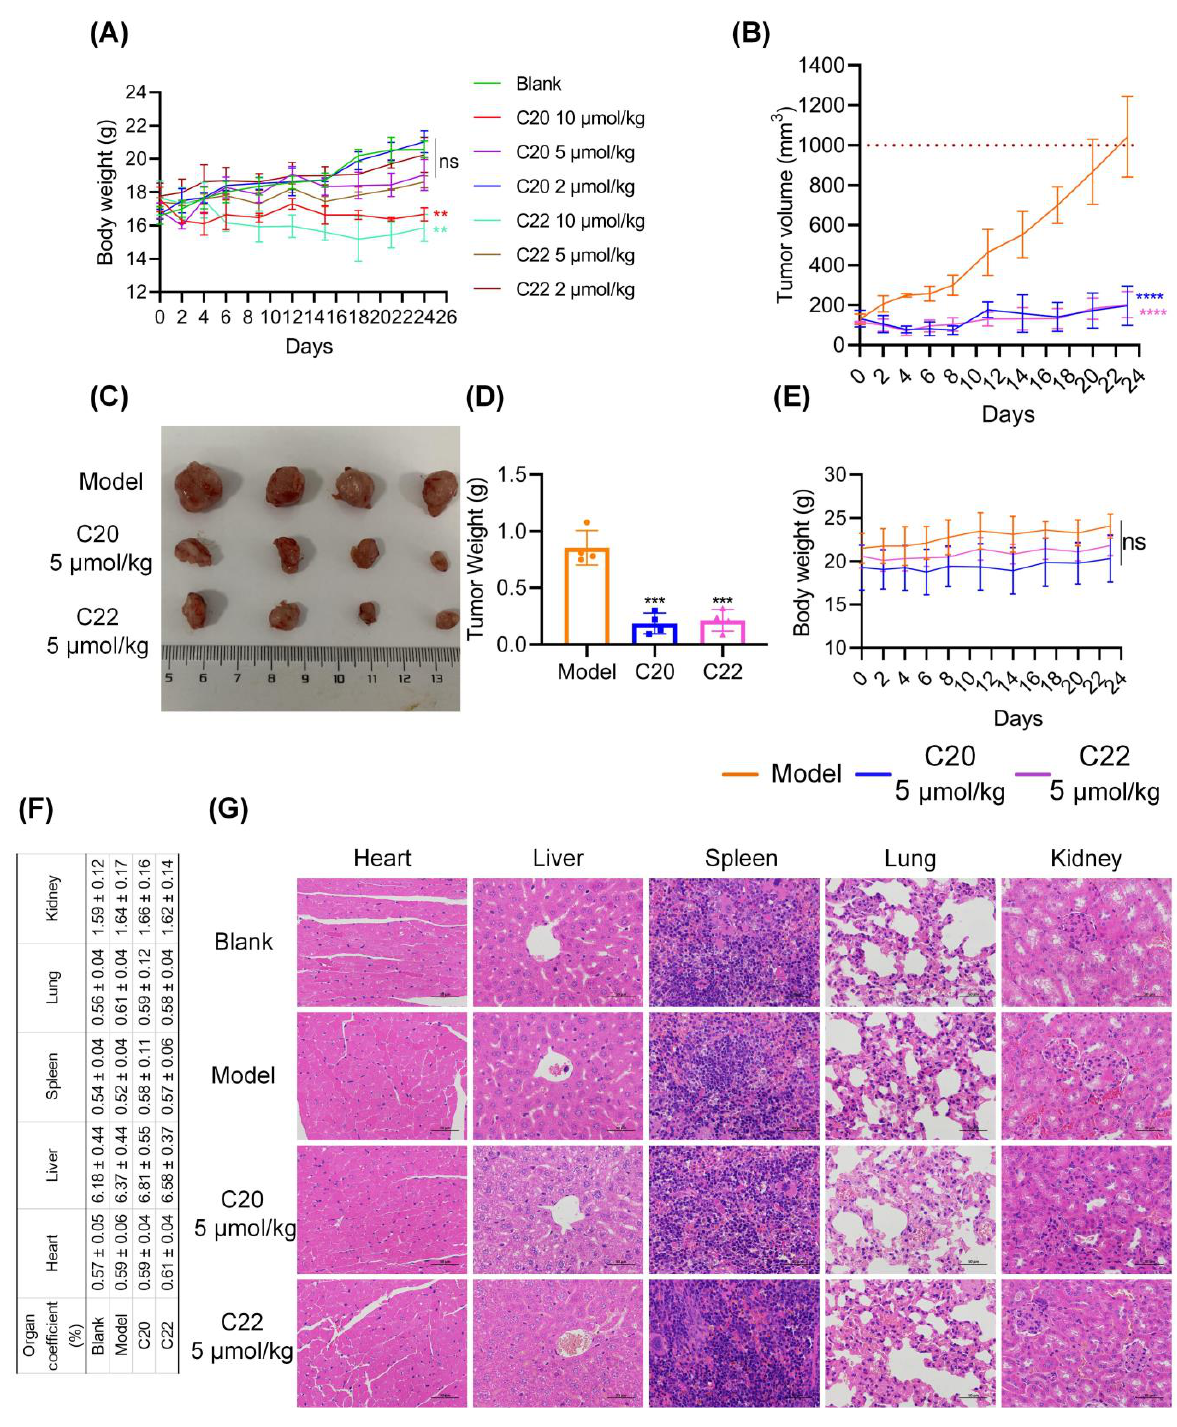
Figure 9. The toxicity and antitumor effects of C20/C22 in vivo. ( A ) In vivo toxicity study of C20/C22, showing the effects of C20/C22 on the body weight ( n = 3). ( B ) Tumor volume of tumor-bearing mice until 24 days post administration ( n = 4). ( C ) Tumor images at 23 days post administration. ( D ) Tumor weight at 23 days post administration. ( E ) Body weight of tumor-bearing mice until 23 days post administration. ( F ) Organ coefficient statistics. ( G ) Histopathology of major organs from xenograft mouse model post administration in comparison to the healthy mice (H&E stain × 400). Scale bars, 50 µ m. The p -value was analyzed by one-way ANOVA followed by Tukey’s test using GraphPad Prism version 8.00. ** p < 0.05, *** p < 0.001, **** p < 0.0001 and ns nonsignificant vs. blank/model